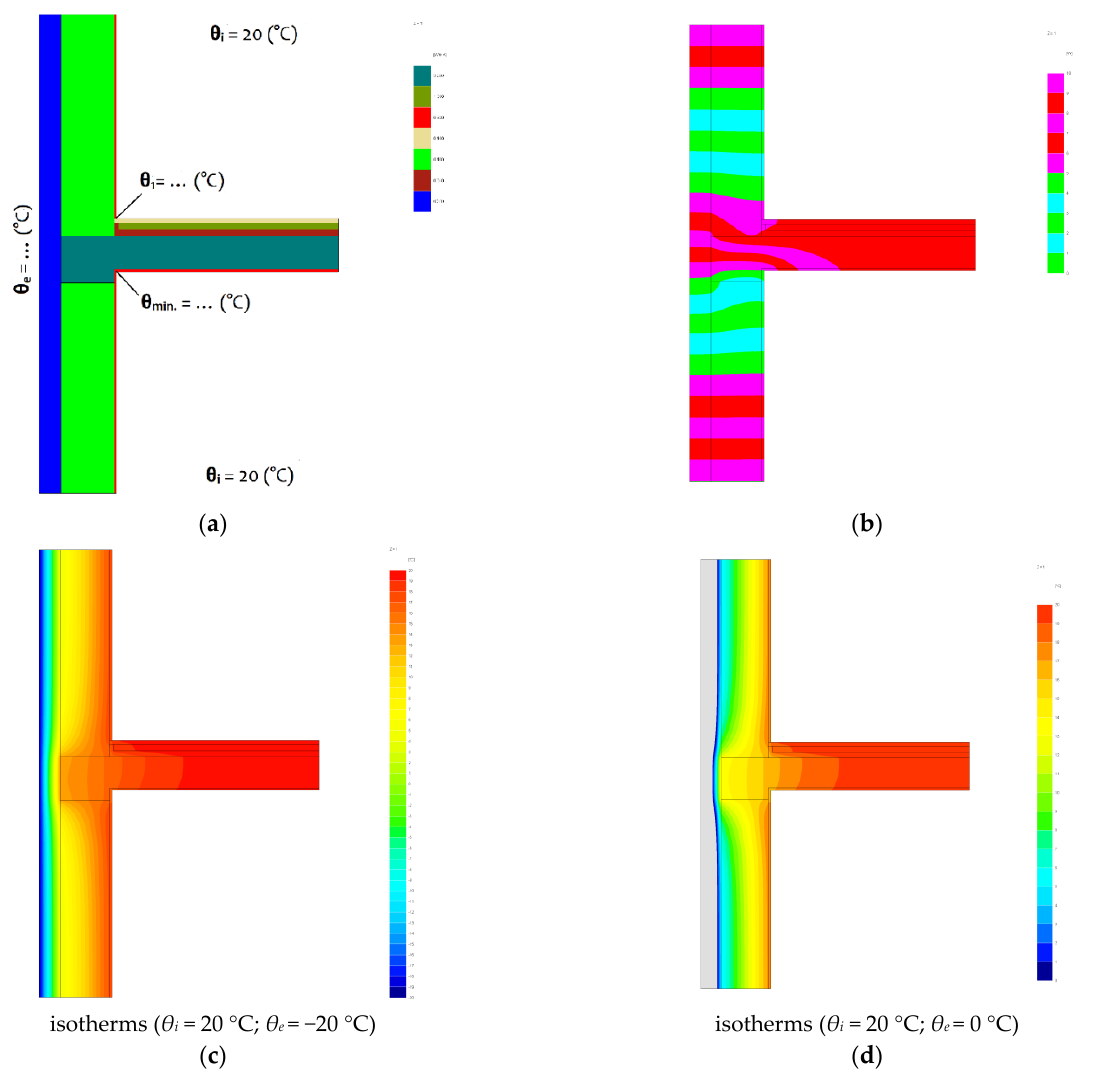
Figure 6. Graphic representation of the simulation results of numerical calculations for the junction of the external wall with the ceiling: ( a ) Calculation model; ( b ) Heat flux lines; ( c), ( d ) Temperature distribution. Table 14. Temperature at the junction of the external wall with the ceiling . Table 13. Temperature at the corners of external